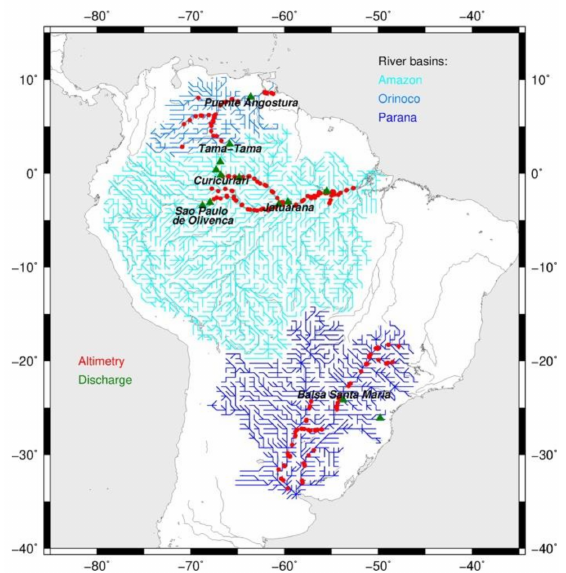
Figure 1. TRIP routing scheme for the Amazon, Orinoco and Parana rivers; radar altimetry virtual stations (red) and GRDC discharge (green)